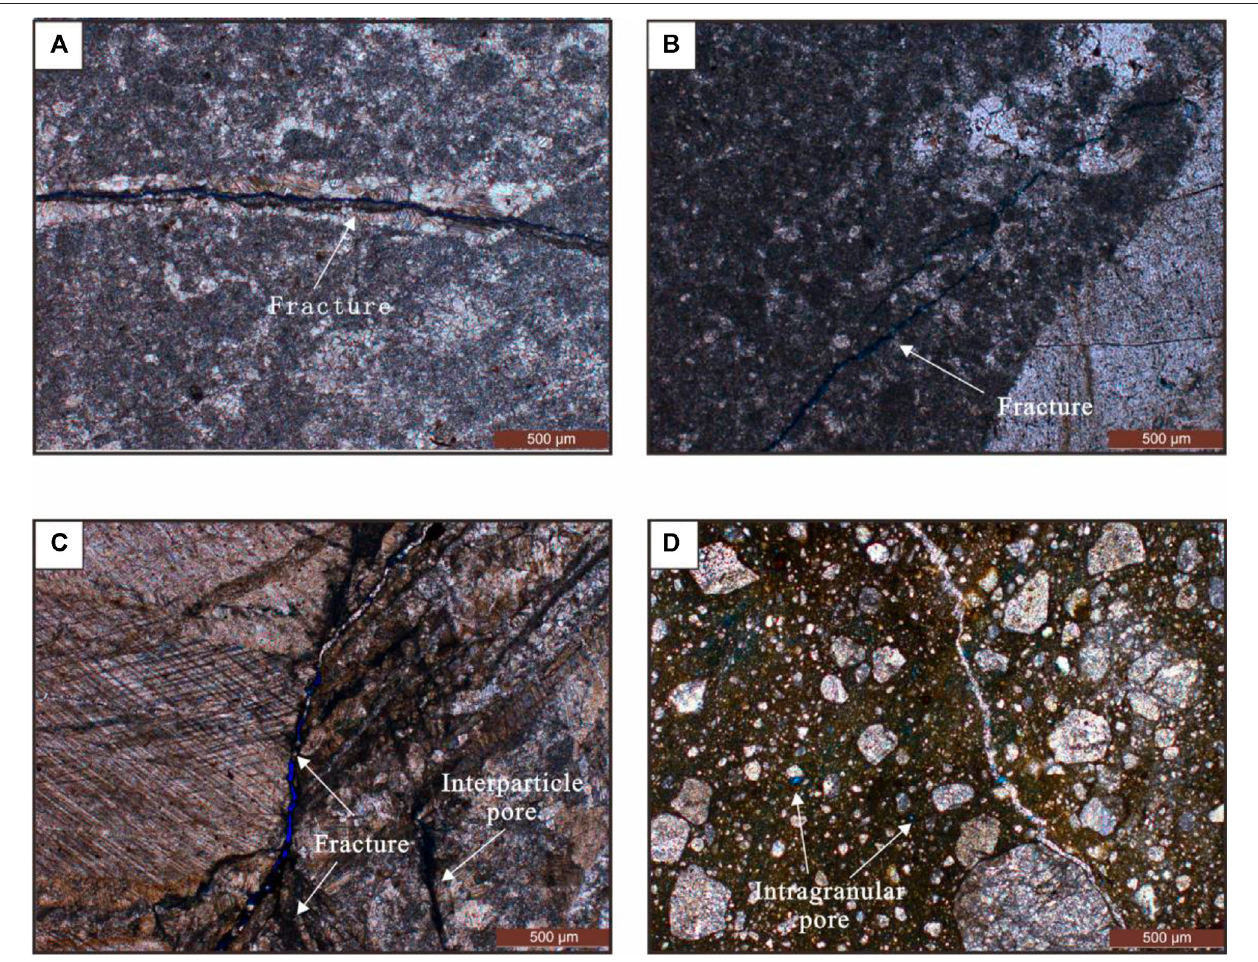
FIGURE6| Microstructurecharacteristics ofhostrock, faultcoreand damagezone. (A) Host rock(XKE1) samplewafer microstructure. (B) Damage zone(XKE 8) sample,andthefracturesarewelldeveloped,andsometimesthefracturesarecementedbythecalcite. (C) Faultbreccia(XKE7),morevisiblefracturesandintergranular pore are developed under microscopic. (D) Fault gouge (XKE 9) in the fault core, embedded in a fi ne-grained matrix, develops intergranular pore.